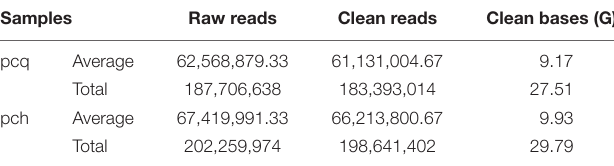
TABLE 2 | Summary of Illumina